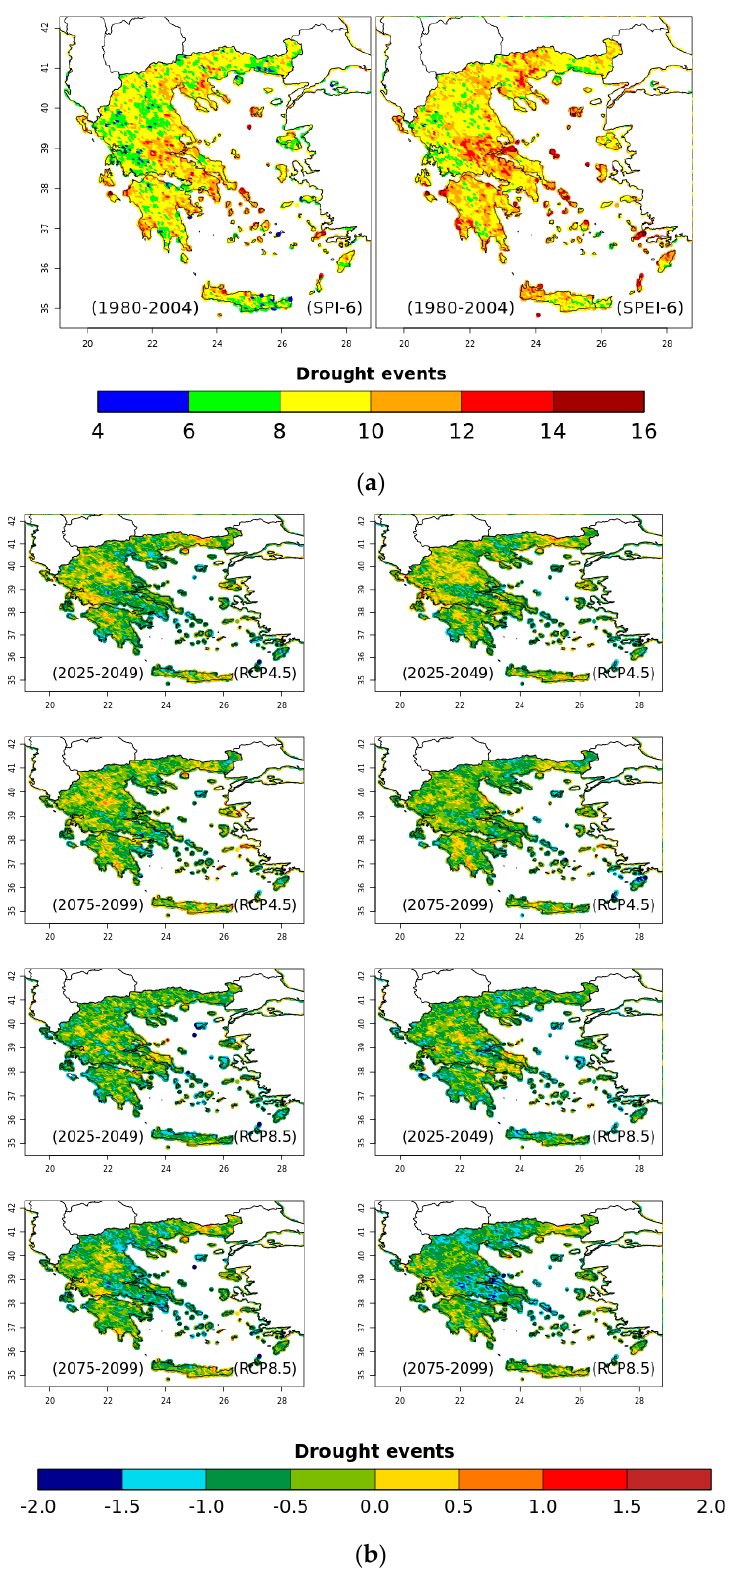
Figure 3. ( a ) Drought frequency as the number of events in 25 years for the reference period (1980 − 2004) for the SPI ( left ) and the SPEI ( right ) indices computed at 6 − month timescale. ( b ) Changes in the frequency for the 6 − month SPI and SPEI for the near future period (2025–2049) and the far future (2075 − 2099) relative to the reference period (1980 − 2004) under RCP4.5 and RCP8.5.